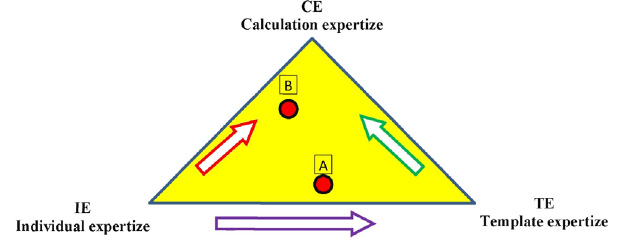
Figure 1. Combinations of